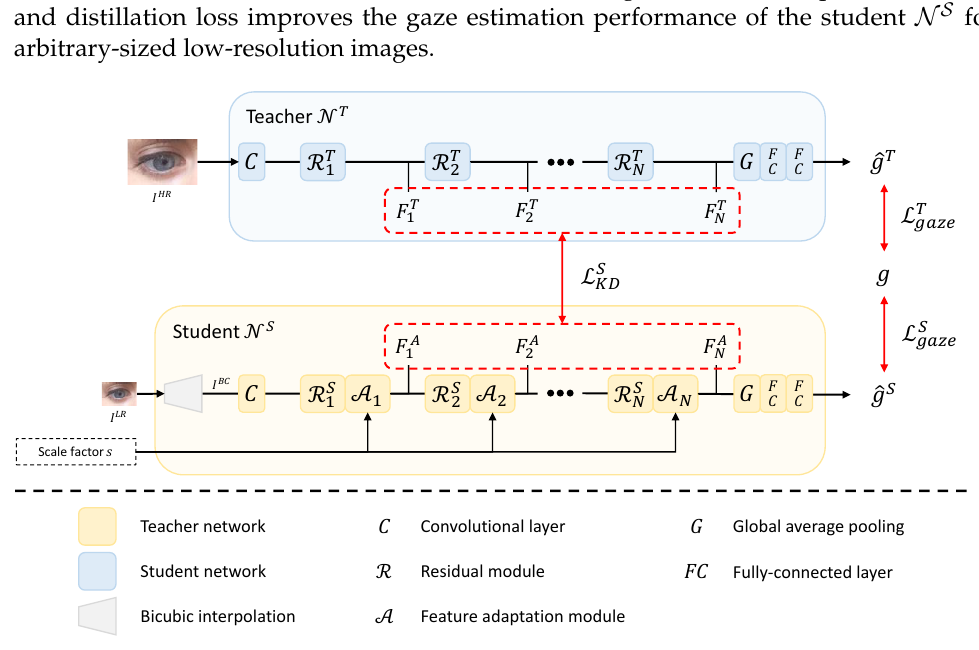
Figure 2. Overview of the proposed